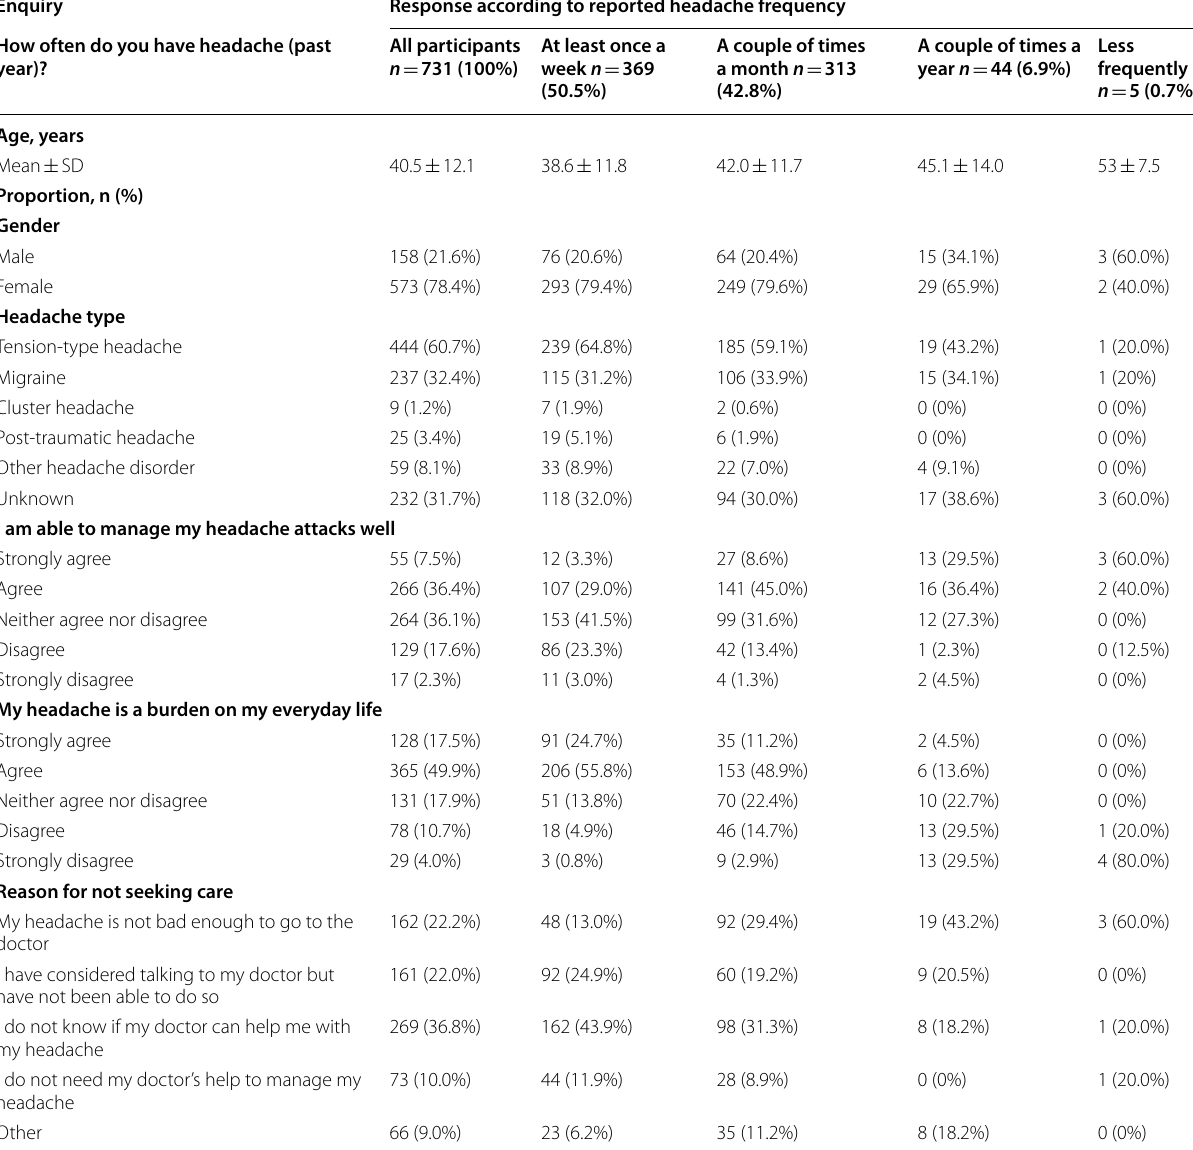
Table 5 Characteristics of all participants not seeking medical advice, and reasons for not doing so Enquiry Response according to reported headache frequency How often do you have headache (past